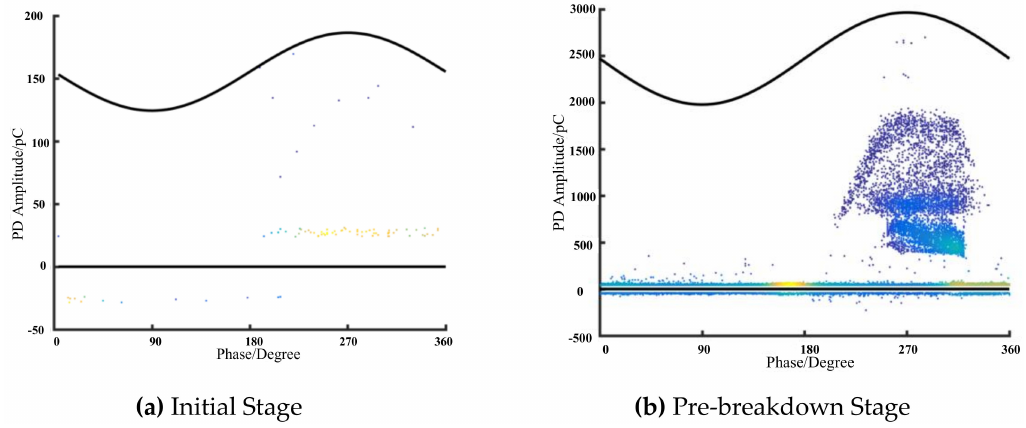
Figure 10. PRPD patterns under AC/DC proportion of